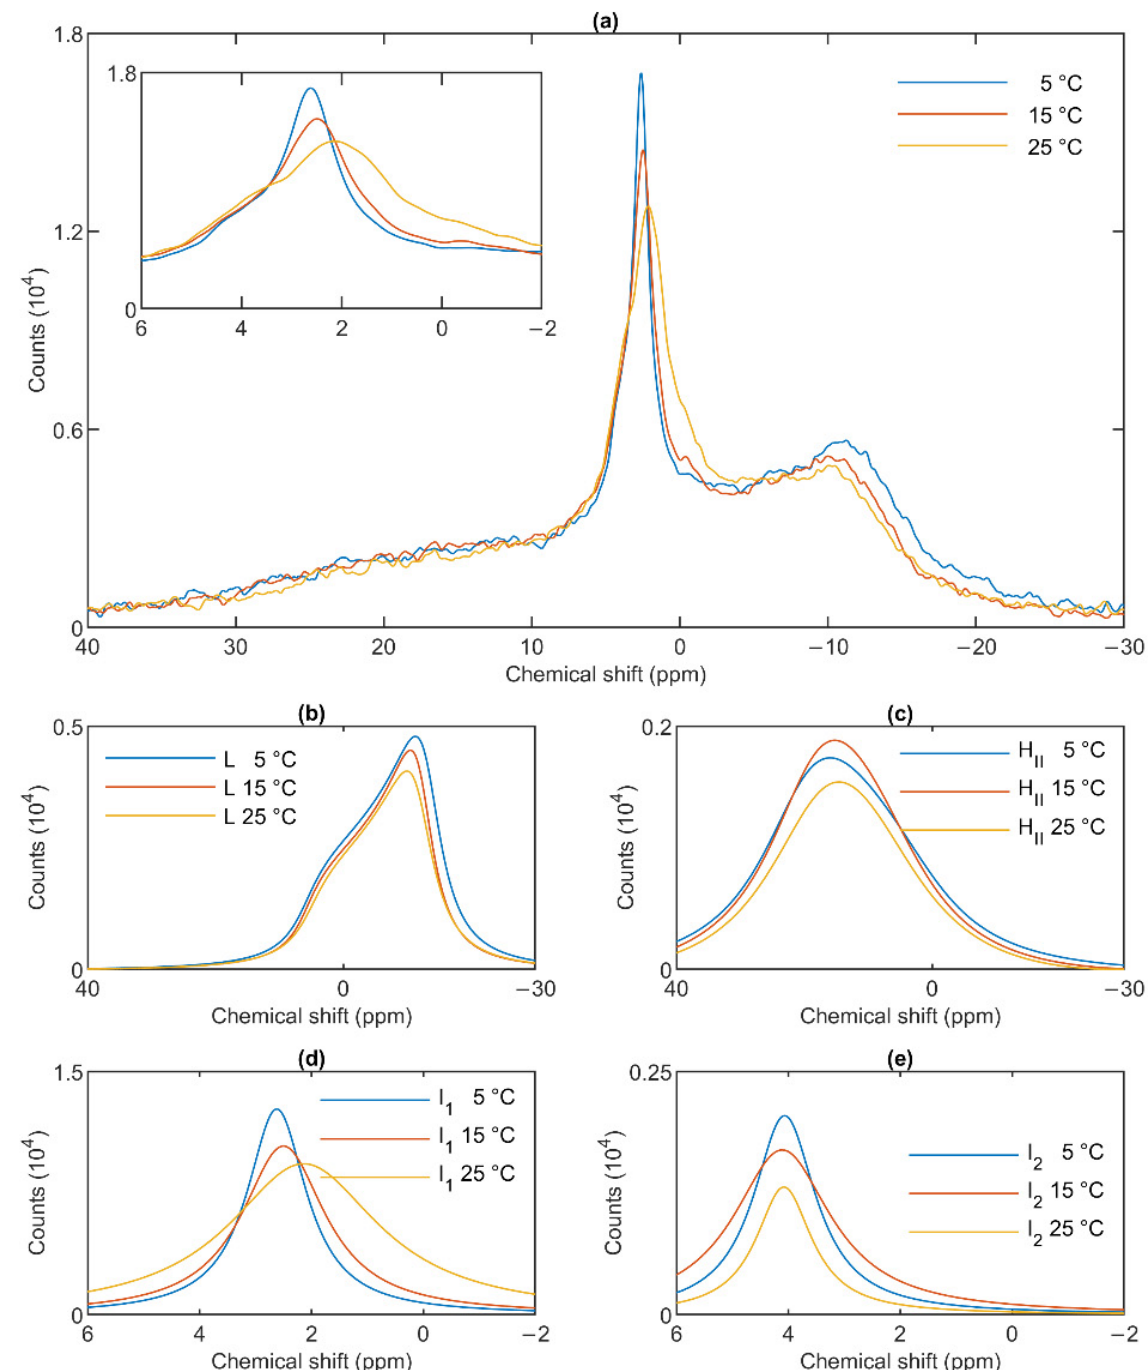
Figure 4. 31 P-NMR spectra of granum thylakoid membranes at different temperatures ( a ) and their component spectra showing variations in L, the lamellar phase ( b ), H II , the inverted hexagonal phase ( c ), and the two isotropic phases, I 1 ( d ) and I 2 ( e ). The experiments were performed by gradually increasing the temperature from 5 to 35 ◦ C, with data acquisition times between 1 and 2 h. Four experiments on three independent batches, with similar polymorphic features, were averaged to improve the signal to noise ratio. The inset in panel a shows the isotropic region.